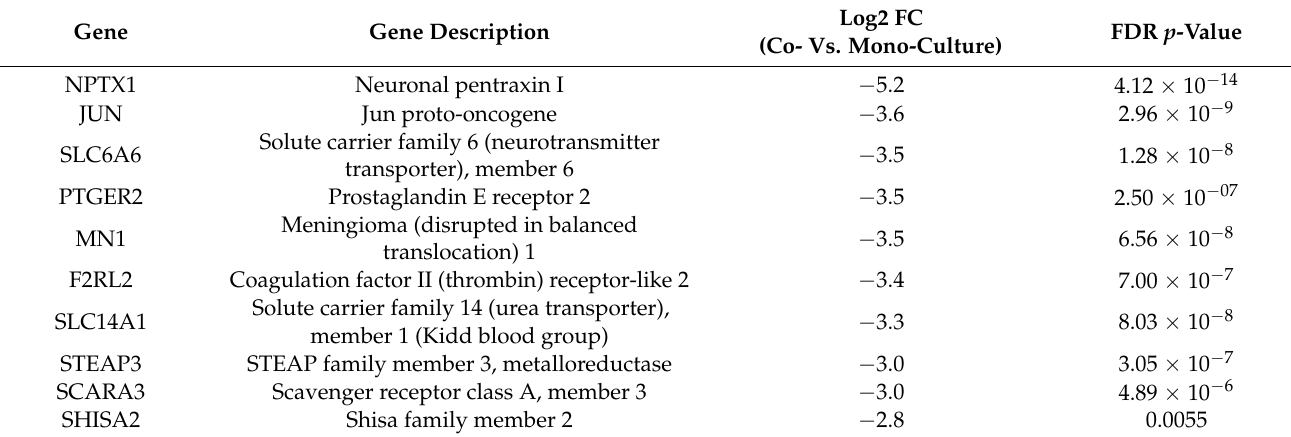
Table 2. Top ten downregulated genes in co-cultured